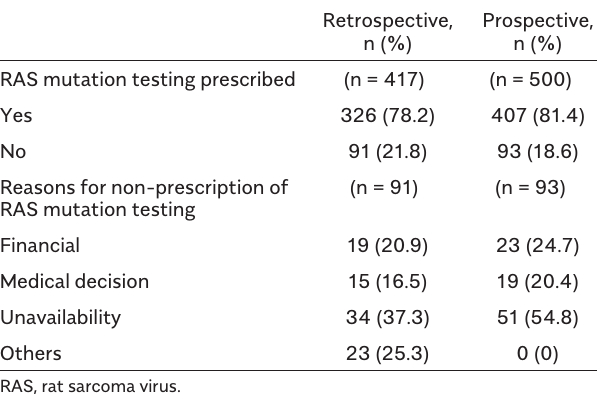
Table 1. Demographic Characteristics Table 2. Rates of RAS Mutation Testing